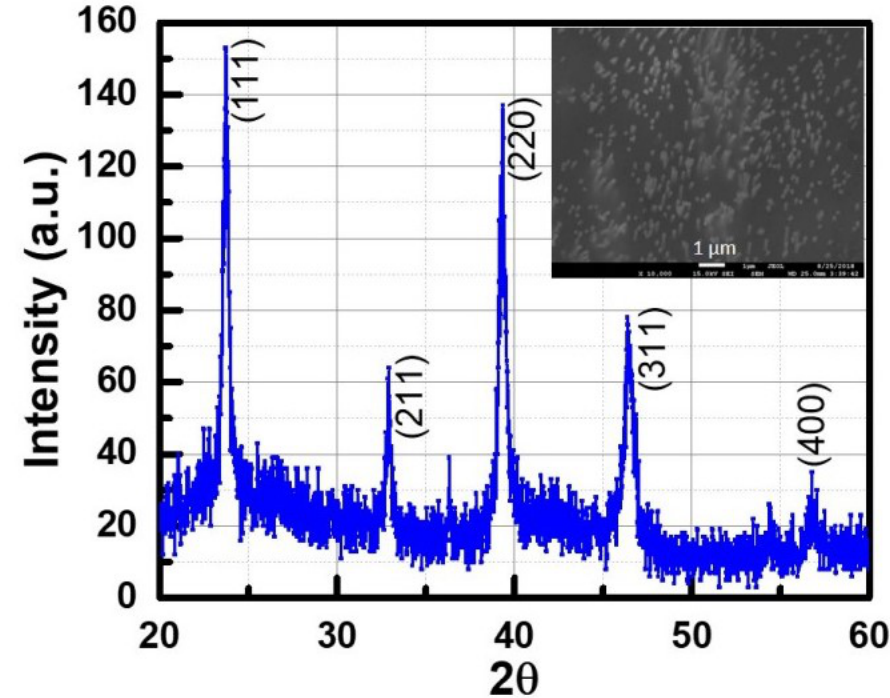
Figure 6. X-ray diffraction (XRD) spectrum of as grown InSb nanowire in polycarbonate